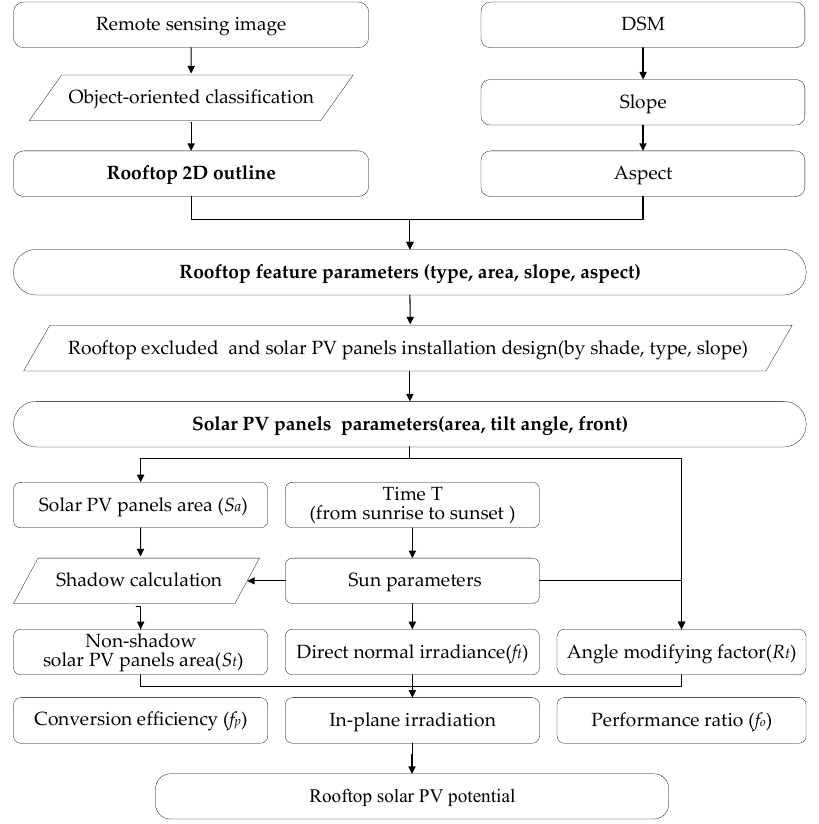
Figure 7. Flowchart of the proposed method.